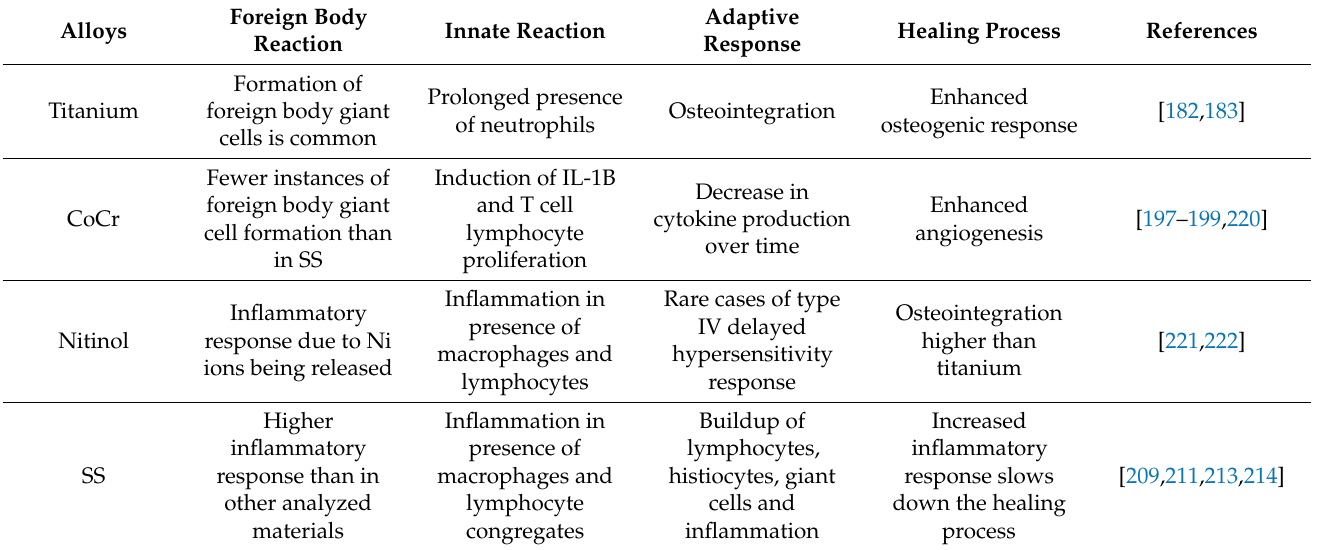
Table 3. Comparison of biocompatible characteristics of titanium, cobalt–chromium, nitinol, and stainless steel